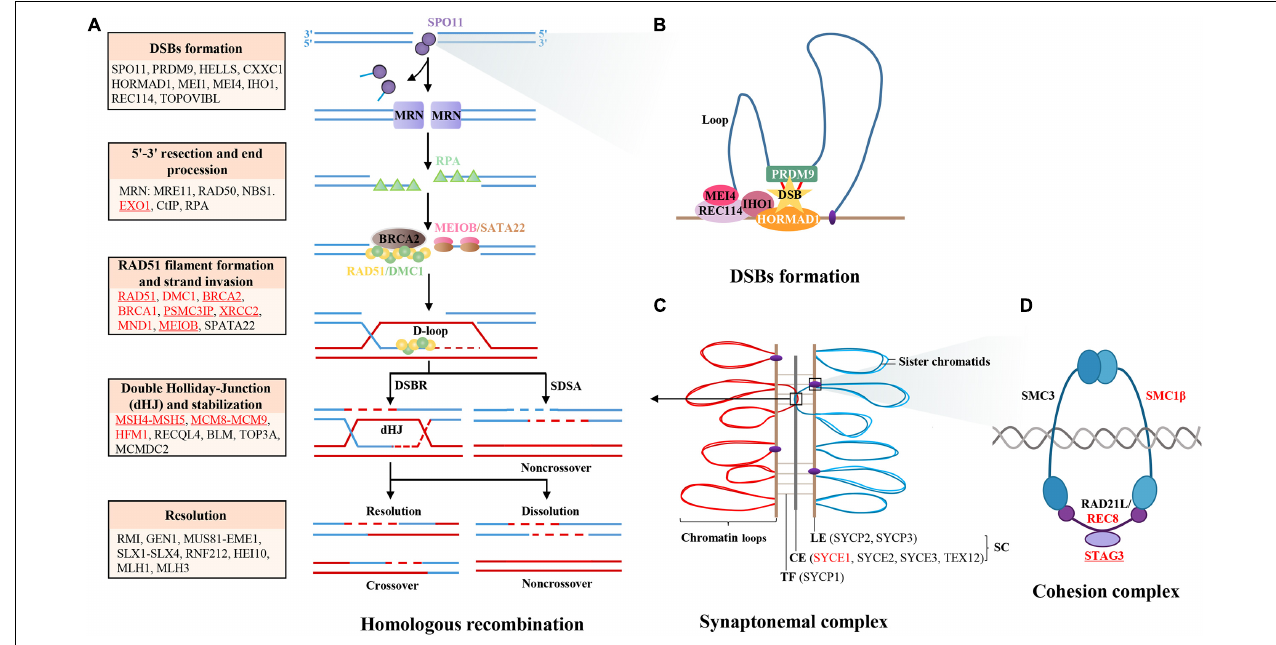
FIGURE 1 | Diagram of meiotic HR genes. (A) Major steps of meiotic prophase I, including DSBs formation, 5 (cid:48) -3 (cid:48) resection, end procession, RAD51 filament formation, strand invasion, intermediates formation, and resolution. The key genes in different steps are labeled in the box, those genes that have been identified in POI patients are labeled with red color, and those that have been functionally validated are underlined. (B) The formation of DSBs is initiated by PRDM9, which binds to chromatin and catalyzes H3K4 trimethylation to mark hotspots. Then, the complex MEI4/REC114/IHO1 binds to HORMAD1 on the axis and activates SPO11 to cut chromatin to form DSBs. (C) The synapsis complex is installed by CE and LE with TF connections in each pair of homologous chromosomes, which establish the platform of HR. (D) The cohesion complex regulates sister chromatid cohesion and SC formation, which is consisted of meiosis-specific subunits